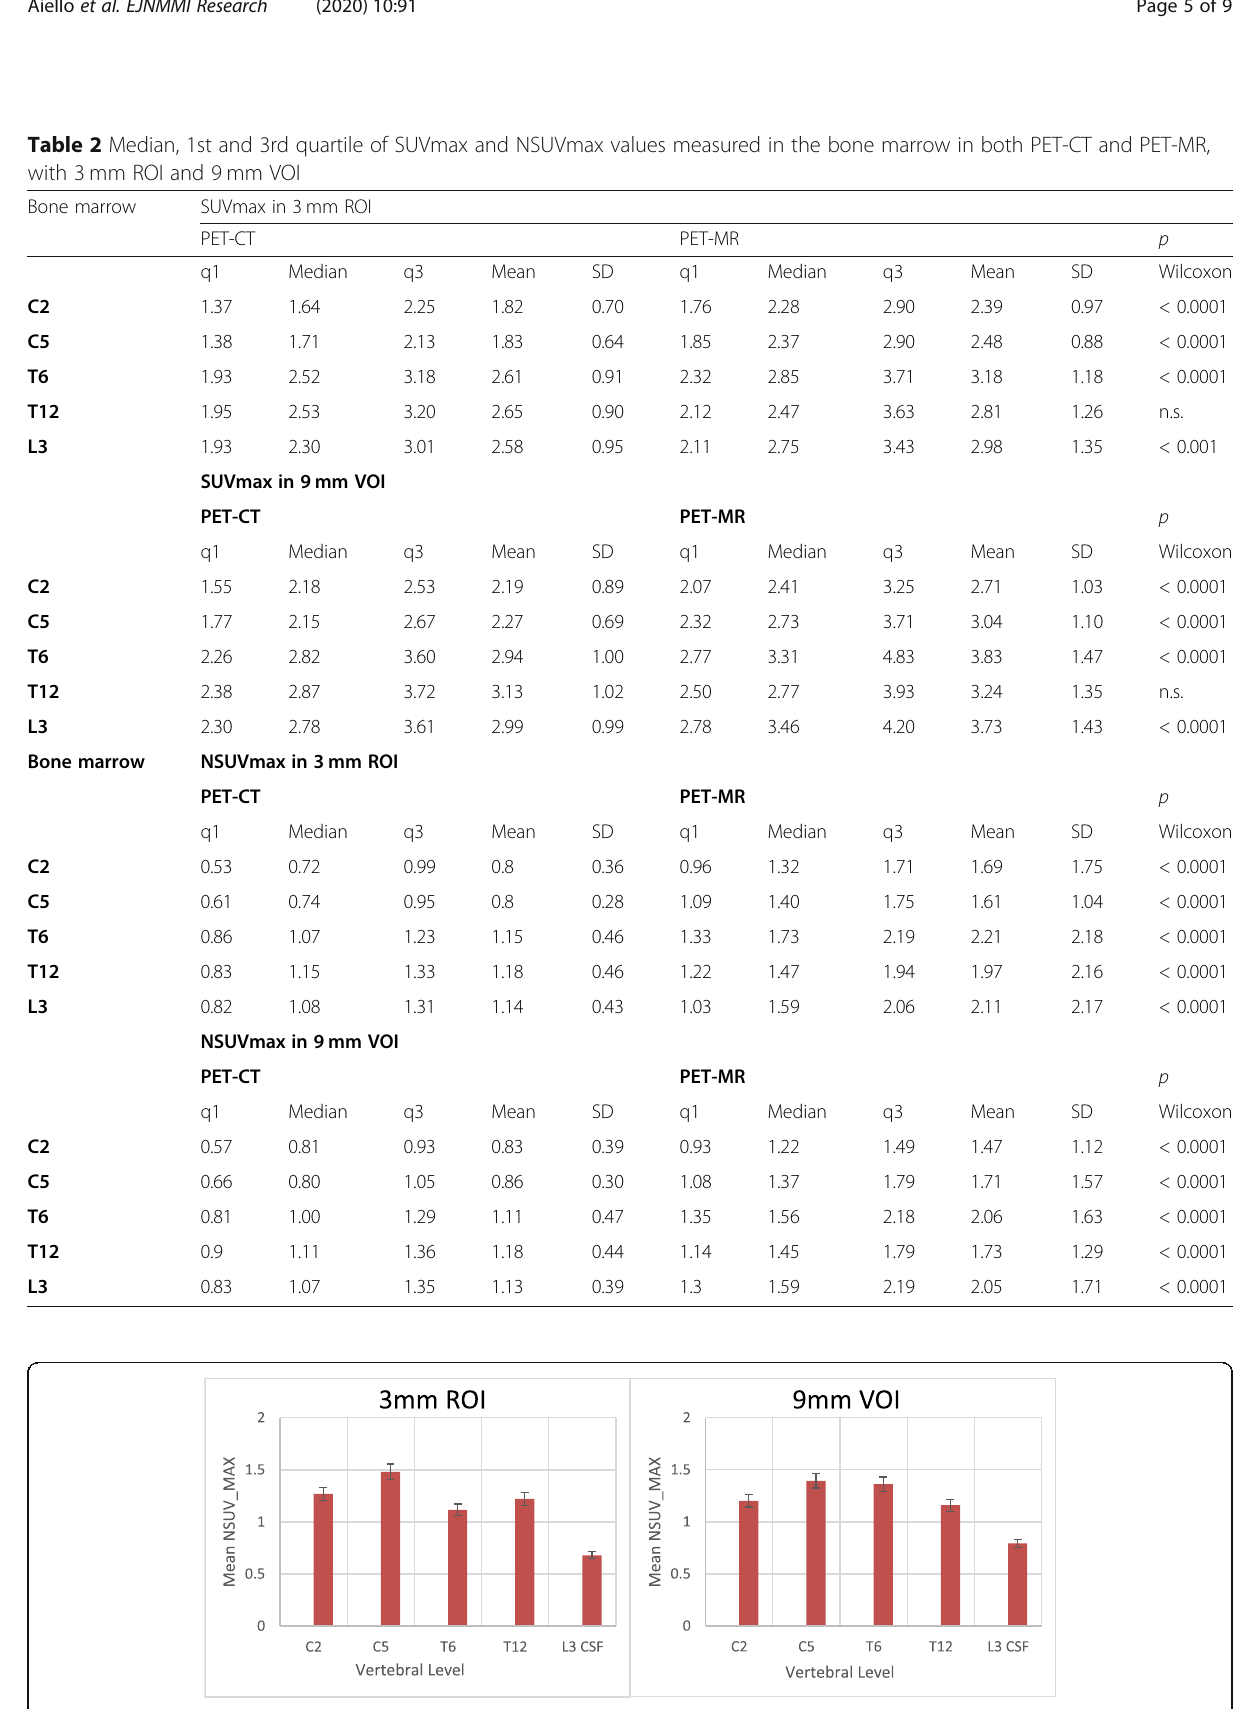
Fig. 2 Mean and SD values of the NSUVmax in PET/MRI of the spinal cord at C2, C5, T6, and T12 levels and of CSF at